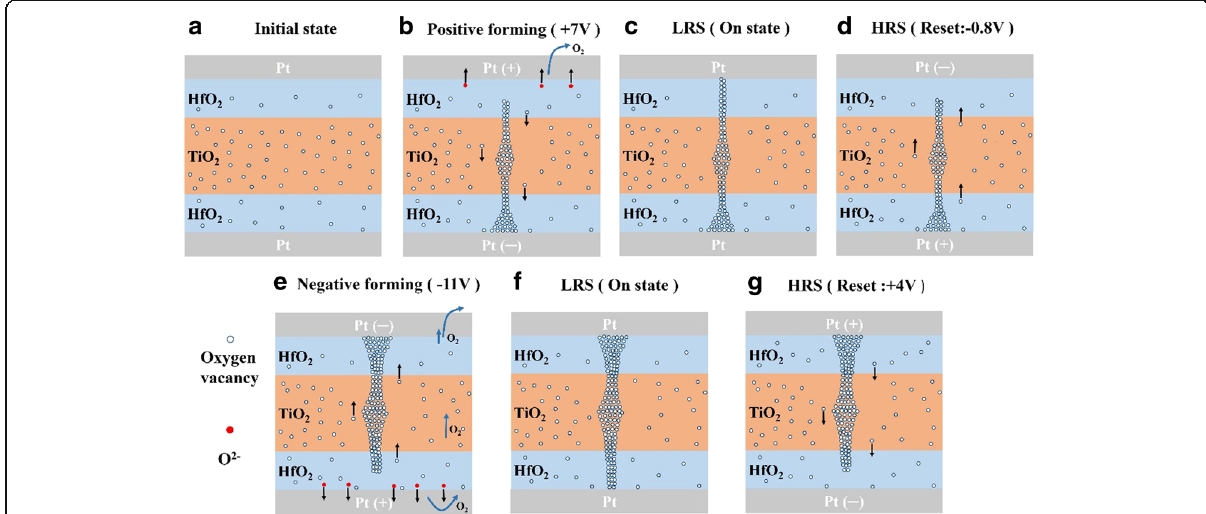
Fig. 8 Schematic diagrams of electroforming and reset of trilayer-structure of HfO 2 /TiO 2 /HfO 2 with symmetric Pt top and bottom electrodes. a – d Electroforming at positive voltage and reset at negative voltage. e – g Electroforming at negative voltage and reset at positive